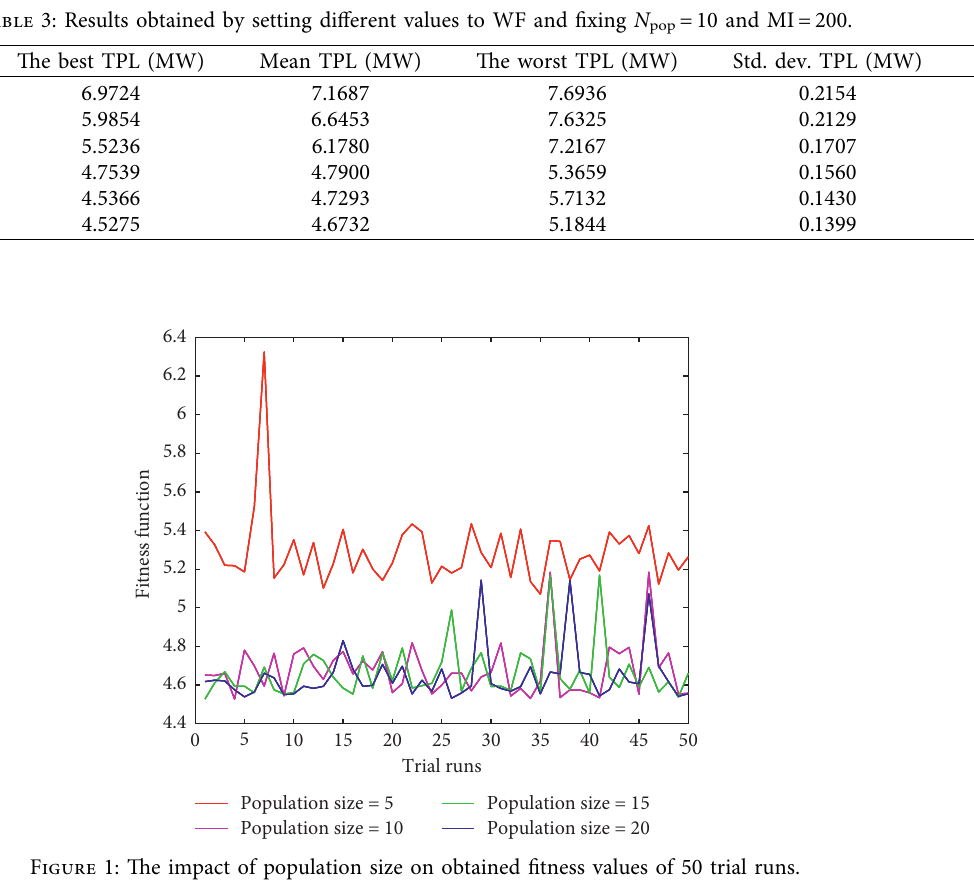
Table 1: Results obtained by setting different values to N Population size The best TPL (MW)